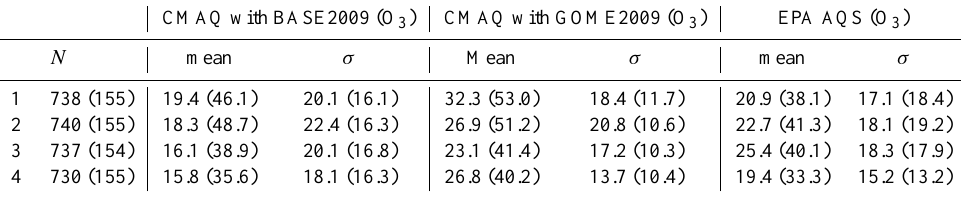
Table 6. The number, the mean, and the standard deviation of the EPA AQS O 3 observations, CMAQ O 3 simulations with the baseline emissions, BASE2009 and CMAQ O 3 simulations with GOME-2 adjusted emissions, GOME2009 at the four EPA AQS O 3 measurement sites (see the right panel of Fig. 7, 1: Houston A, 2: Houston B, 3: Beaumont, and 4: Sulphur). The parentheses indicate the corresponding data during the daytime